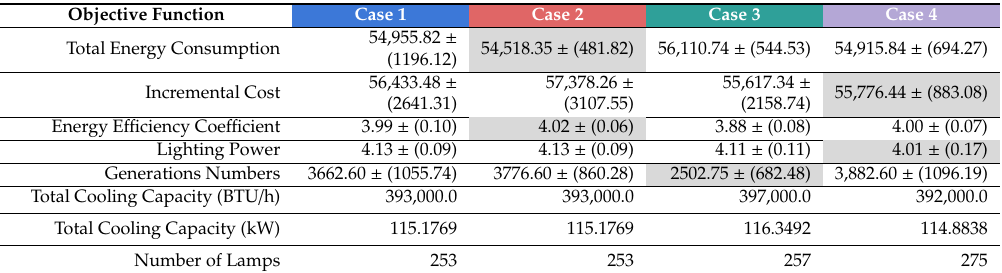
Table 4. Evaluation of the results obtained in the experiments to analyze the best case for the fitness function formation of proposed methodology—With Baits.